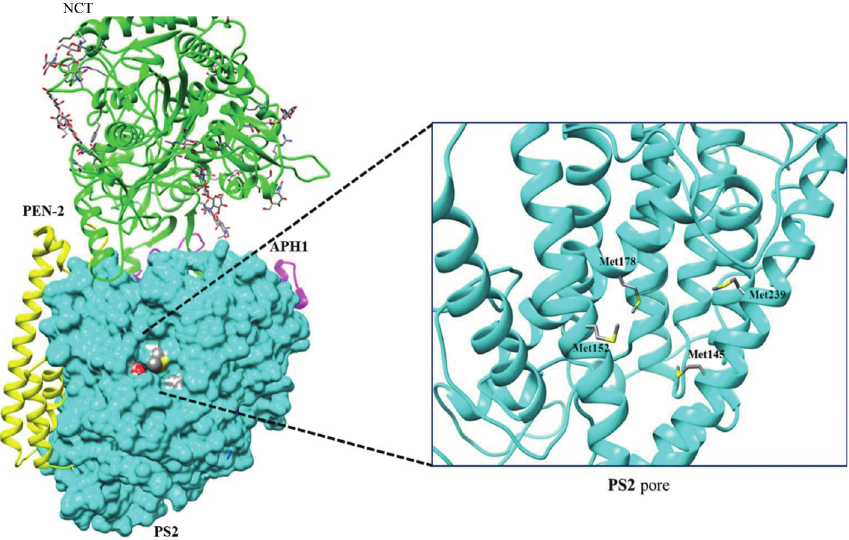
Figure 3: Visualization of the c -secretase complex and ribbon representation of the first methionine access ring in Met145, Met152, Met178, and